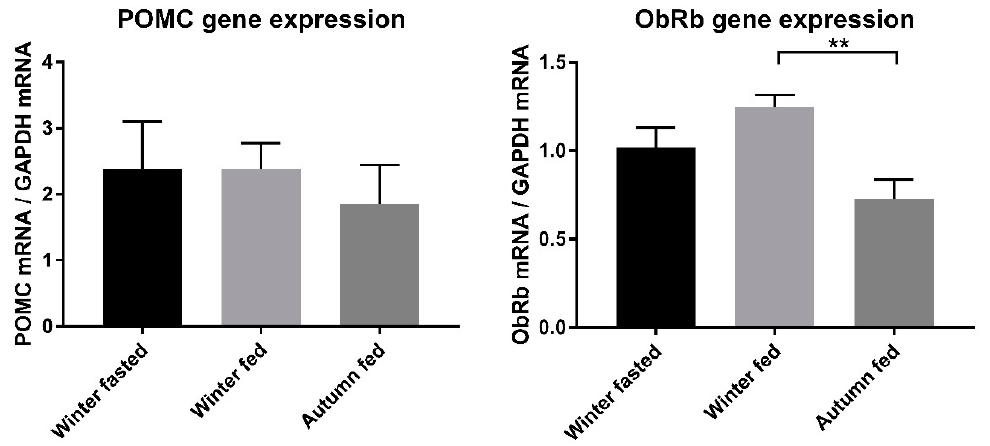
Figure 2. Relative mRNA level expression of anorexigenic POMC and ObRb normalized to the expression of GAPDH in raccoon dog hypothalamus. Statistically significant difference is indicated with ** p ≤ 0.01.